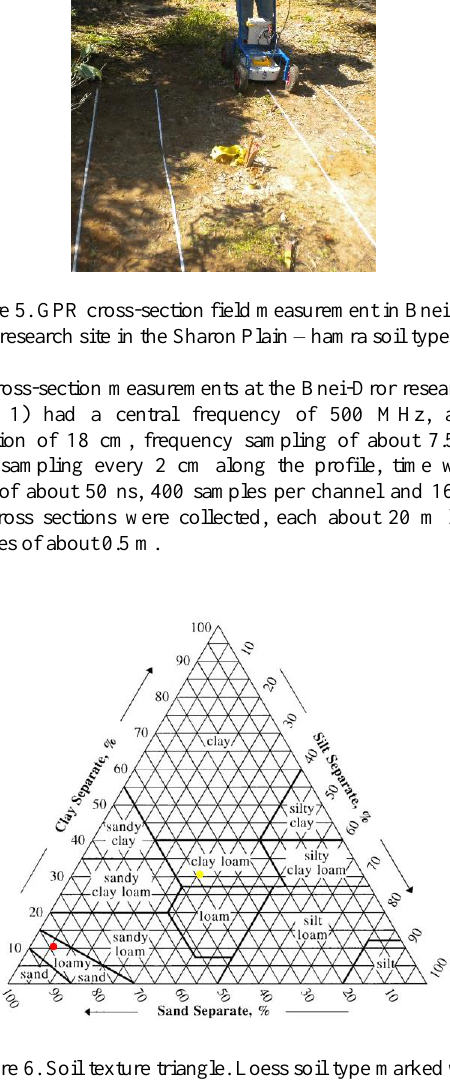
Figure 6. Soil texture triangle. Loess soil type marked with yellow dot, hamra soil type with red